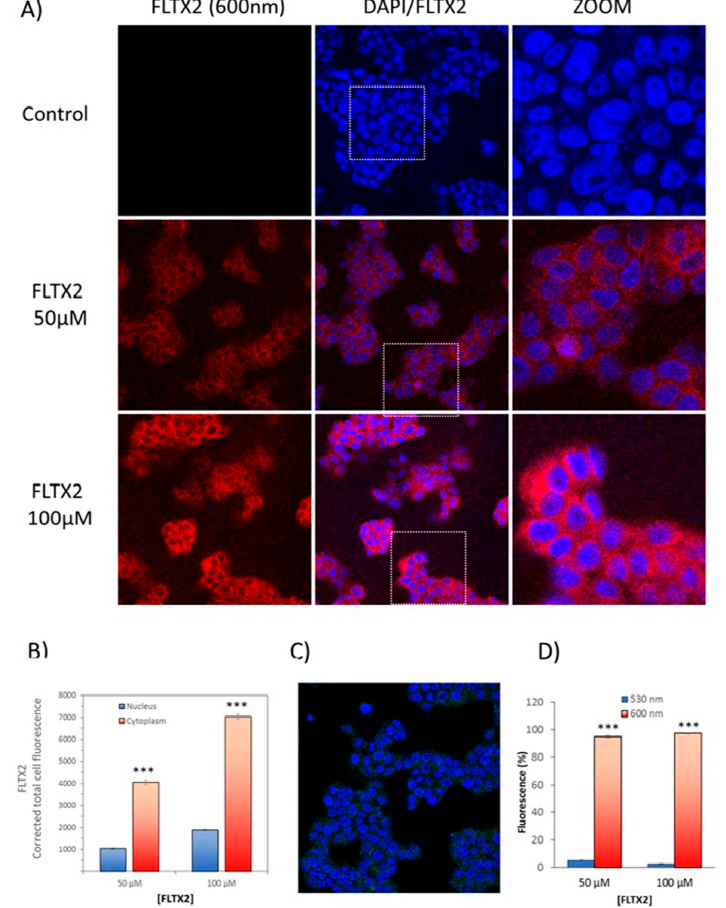
Figure 7. Cellular labeling of FLTX2 and occurrence of FRET in MCF-7 cells. ( A ) Representative images of irradiated preparations (450 nm, 30 min) incubated with different concentrations of FLTX2 (0, 50, and 100 µ M). Fluorescent signals were recorded at the emission band of RB (600 nm). DAPI was used as nuclear marker. ( B ) Concentration-dependent fluorescent signals in cytoplasmic and nuclear compartments. ( C ) Demonstration of FRET efficiency in FLTX2 irradiation. Fluorescent signal was virtually absent at the emission wavelength of the NBD moiety of FLTX1. ( D ) bar chart comparing fluorescence signals recorded at 530 nm (NBD moiety) and 600 nm (NBD to RB transfer). *** Statistically significant at p < 0.005.